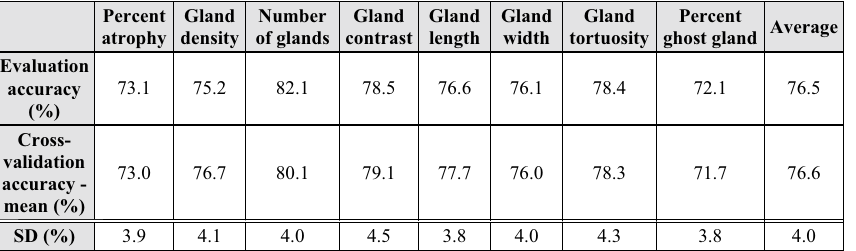
Table 3. Classification accuracy for morphological feature prediction of the attribute learning model. The model predicts the gland morphological features with an average accuracy of 77%. Note that the second row reports accuracies on the evaluation set and the last two rows reports means and standard deviations of accuracies on the five-fold cross-validation set.